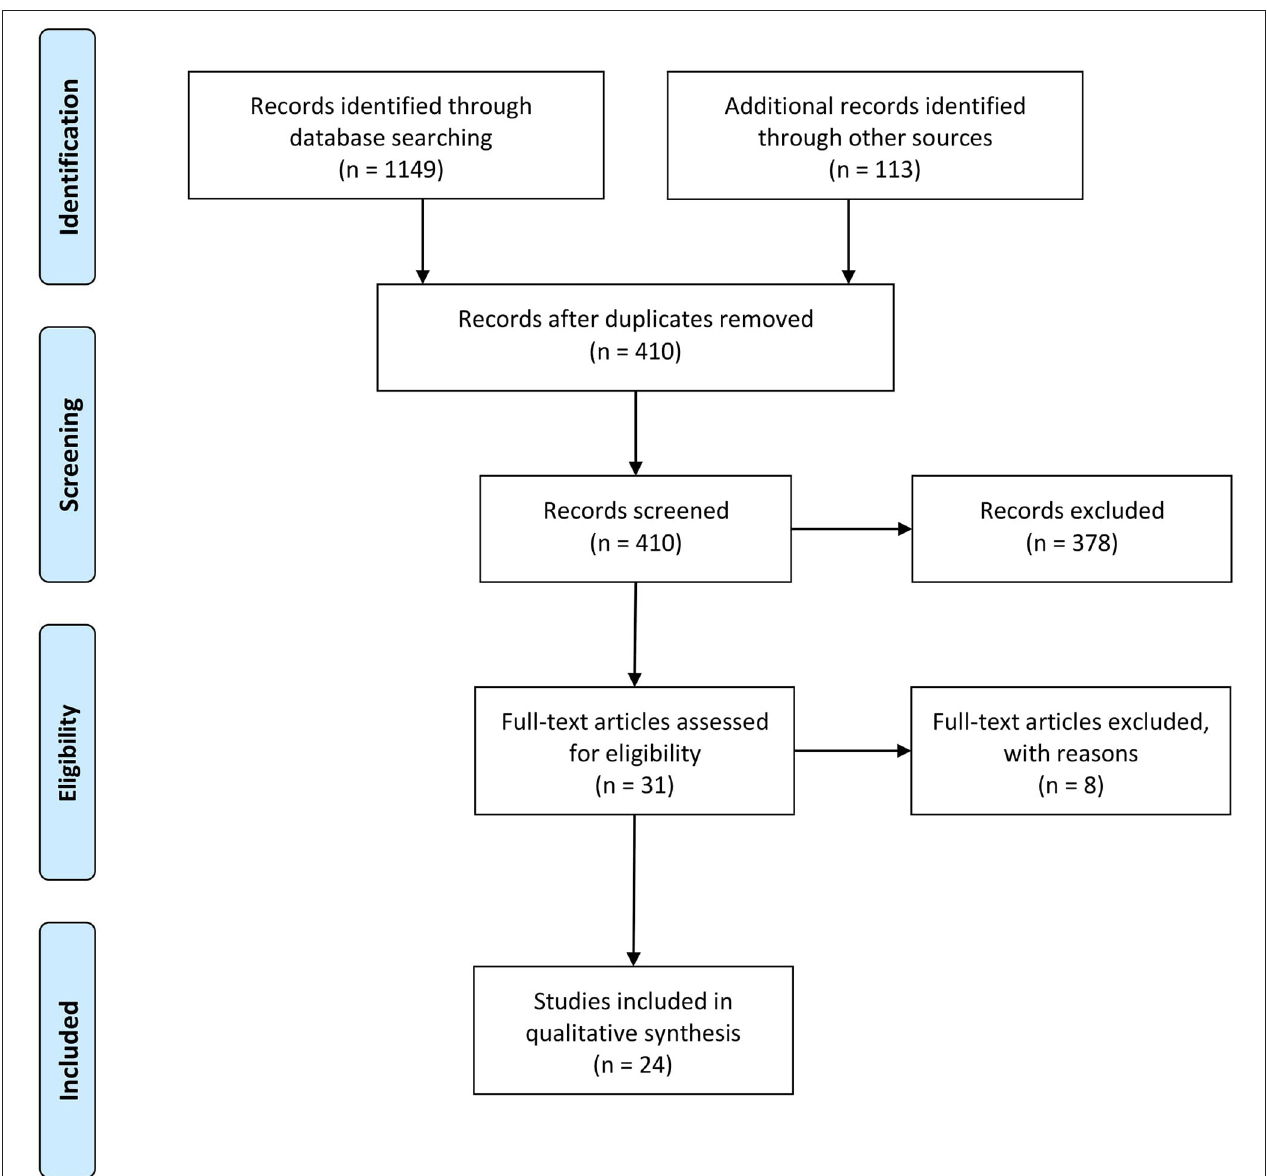
FIGURE 1 | Flow diagram based on Prisma, based on Moher et al. (2009).